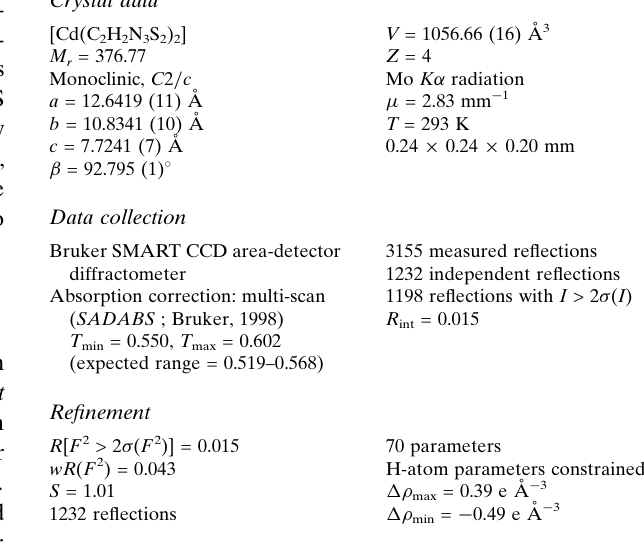
Experimental Crystal data